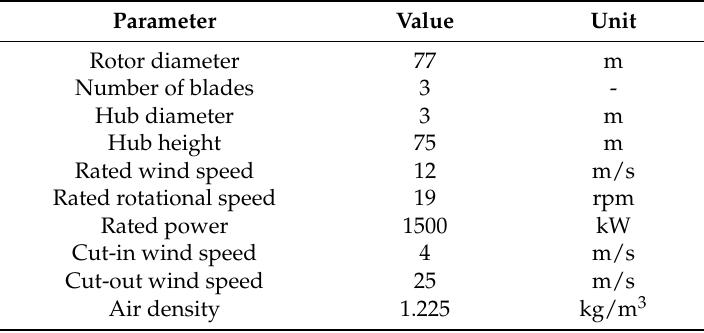
Table 3. Basic parameters of the commercial 1.5 MW blade.